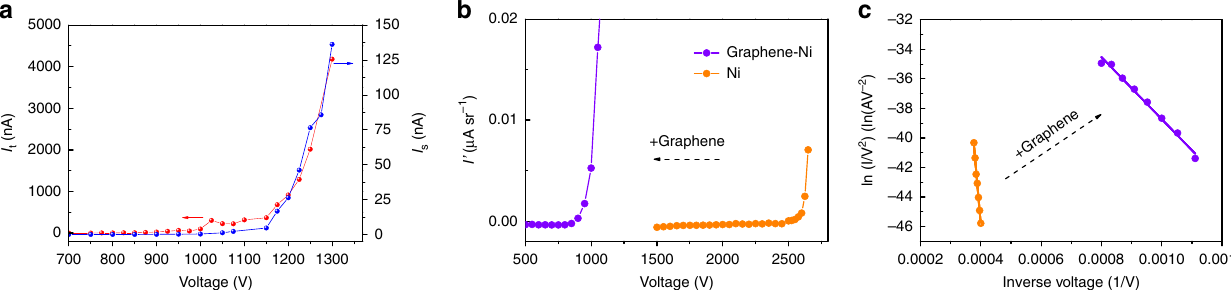
Fig. 2 Characterization of the grown graphene. a EDS spectra of the Ni tip before (black) and after (red) graphene coating. b Typical Raman spectra obtained from the surface of Ni tip coated with graphene with a 532 nm excitation laser. c Hexagonal electron diffraction pattern of graphene surface. Scale bar, 5 nm − 1 . d High-resolution TEM image of the graphene surface showing the lattice fringes, and inset is the corresponding FFT pattern from the TEM image. e HRTEM image on the edge of the graphene fl ake. Scale bar, 5 nm ( d , e